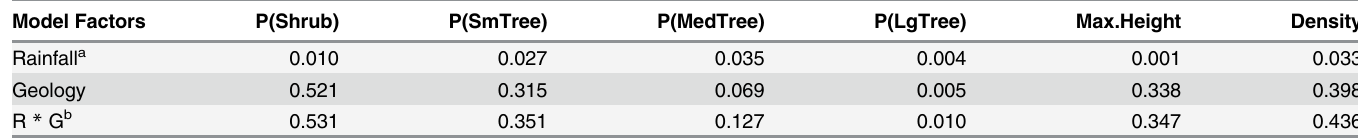
Table 1. Proportion of variation (R 2 ) explained by geology and rainfall in models for each of the six vegetation structure metrics. Model